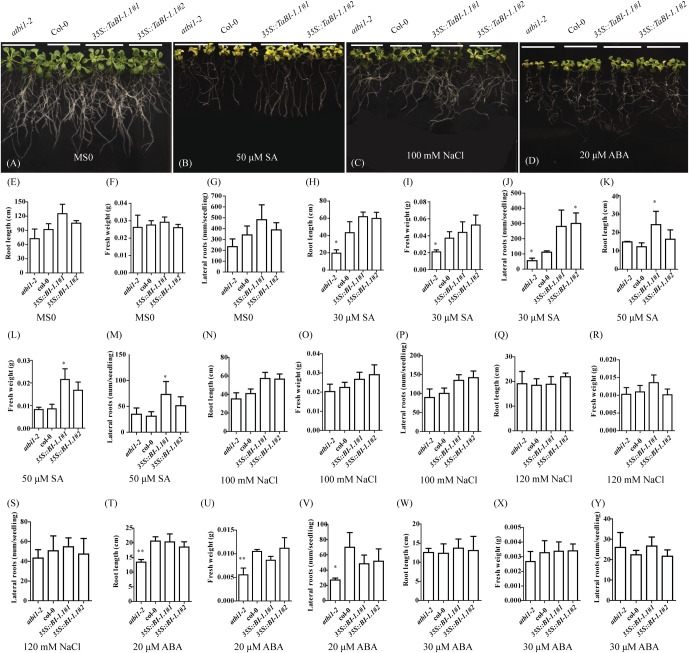
Statistical analysis of seedling root length, fresh weight, and lateral root numbers of atbi1-2, Col-0, and 35S::TaBI-1.1 transgenic Arabidopsis grown on MS media containing SA, NaCl, or ABA. Growth phenotype of atbi1-2, Col-0, and the two 35S::TaBI-1.1 transgenic seedlings on (A) MS0 medium, (B) MS medium containing 50 μM SA, (C) MS medium containing 100 mM NaCl, and (D) MS medium containing 20 μM ABA. After stratification, seedlings were grown in MS0 medium for 4 days in a horizontal position and then transported to MS media containing different concentrations of SA, NaCl, and ABA and grown for 13 days in a vertical position. These experiments were repeated with nine biological replicates, and the photographs show three representative seedlings of four genotypes. Statistical analysis of the root length of atbi1-2, Col-0, and the two 35S::TaBI-1.1 transgenic lines on MS0 (E), MS media containing 30 μM SA (H), 50 μM SA (K), 100 mM NaCl (N), 120 mM NaCl (Q), 20 μM ABA (T), and 30 μM ABA (W). Statistical analysis of the fresh weight of atbi1-2, Col-0, and the two 35S::TaBI-1.1 transgenic lines on MS0 (F), MS media containing 30 μM SA (I), 50 μM SA (L), 100 mM NaCl (O), 120 mM NaCl (R), 20 μM ABA (U), and 30 μM ABA (X). Statistical analysis of the root length of atbi1-2, Col-0, and the two 35S::TaBI-1.1 transgenic lines on MS0 (G), MS media containing 30 μM SA (J), 50 μM SA (M), 100 mM NaCl (P), 120 mM NaCl (S), 20 μM ABA (V), and 30 μM ABA (Y). Error bars indicate the SDs. The data represent the means ± SDs of nine independent biological replicates. Asterisks indicate significant differences (∗P < 0.05 and ∗∗P < 0.01) compared with Col-0 (Student’s t-test).